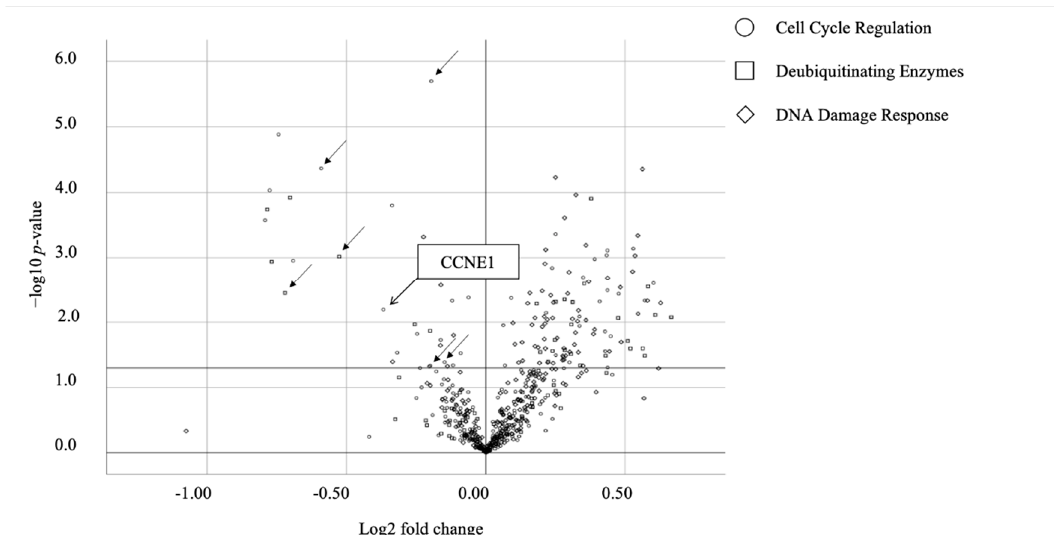
Figure 2. Volcano plot of siRNA library screening using RMG-I. Among 506 genes, seven candidates were extracted; loss of these candidate genes significantly lowered the viability of the ARID1A -knockdown cells compared to that of the control cells ( n = 3 per group). Circle indicates cell cycle regulation-related genes, square indicates deubiquitinating genes and rhombus indicates DNA damage response-related genes. Arrows indicate the seven candidates. The x -axis reflects the logarithm of cell survival rate compared to the control.